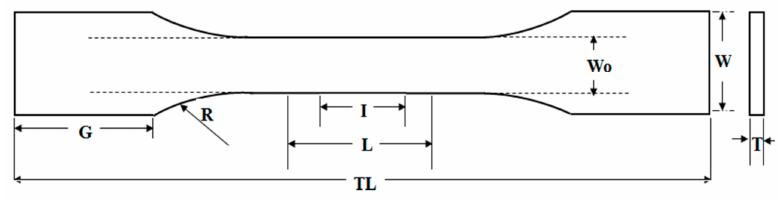
Figure 3. Schematic drawings of dumbell specimen according to ASTM D638 Type 5 [13]. Table 2. Dimension of a dumbbell specimen (ASTM D638 Type V).